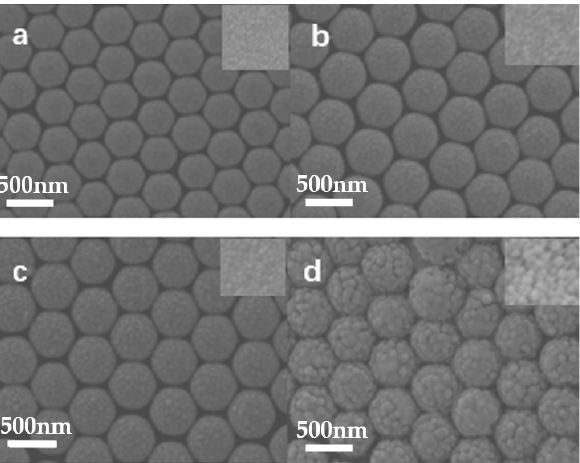
Figure 2. SEM images of Ag/ZnS (( a ) 0 min, ( b ) 5 min, ( c ) 10 min, ( d ) 15 min) films on a PS array.